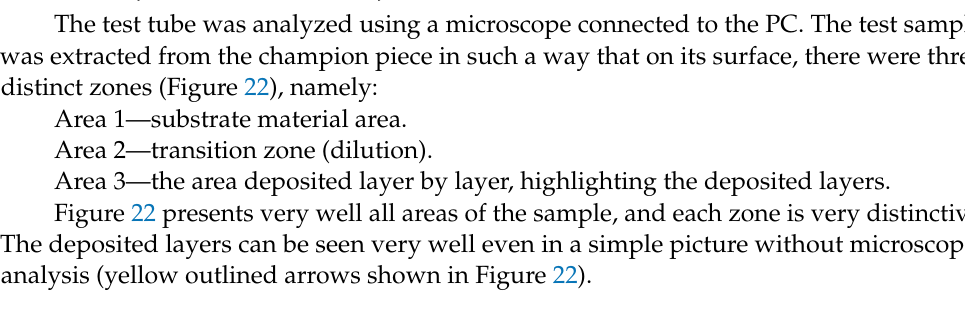
Figure 22. Highlighting microscopically analyzed areas. 3.5. Microscopic Examination—Interpretation The test tube was analyzed using a microscope connected to the PC. The test sample was extracted from the champion piece in such a way that on its surface, there were three distinct zones (Figure 22), namely: Area 1—substrate material area. Area 2—transition zone (dilution). Area 3—the area deposited layer by layer, highlighting the deposited layers. Figure 22 presents very well all areas of the sample, and each zone is very distinctive. The deposited layers can be seen very well even in a simple picture without microscopic analysis (yellow outlined arrows shown in Figure 22).